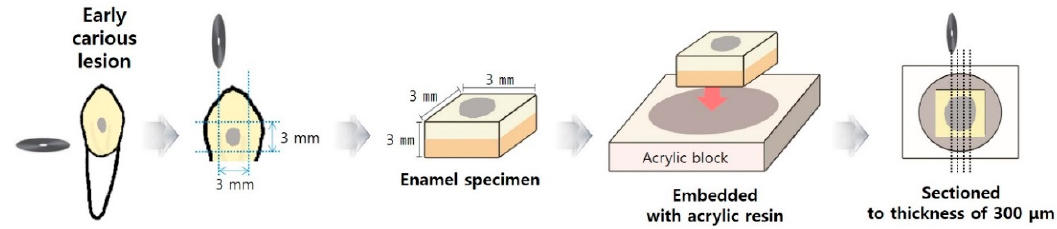
Figure 1. Schematic diagram illustrating the sample preparation for confocal laser scanning microscopy (CLSM)